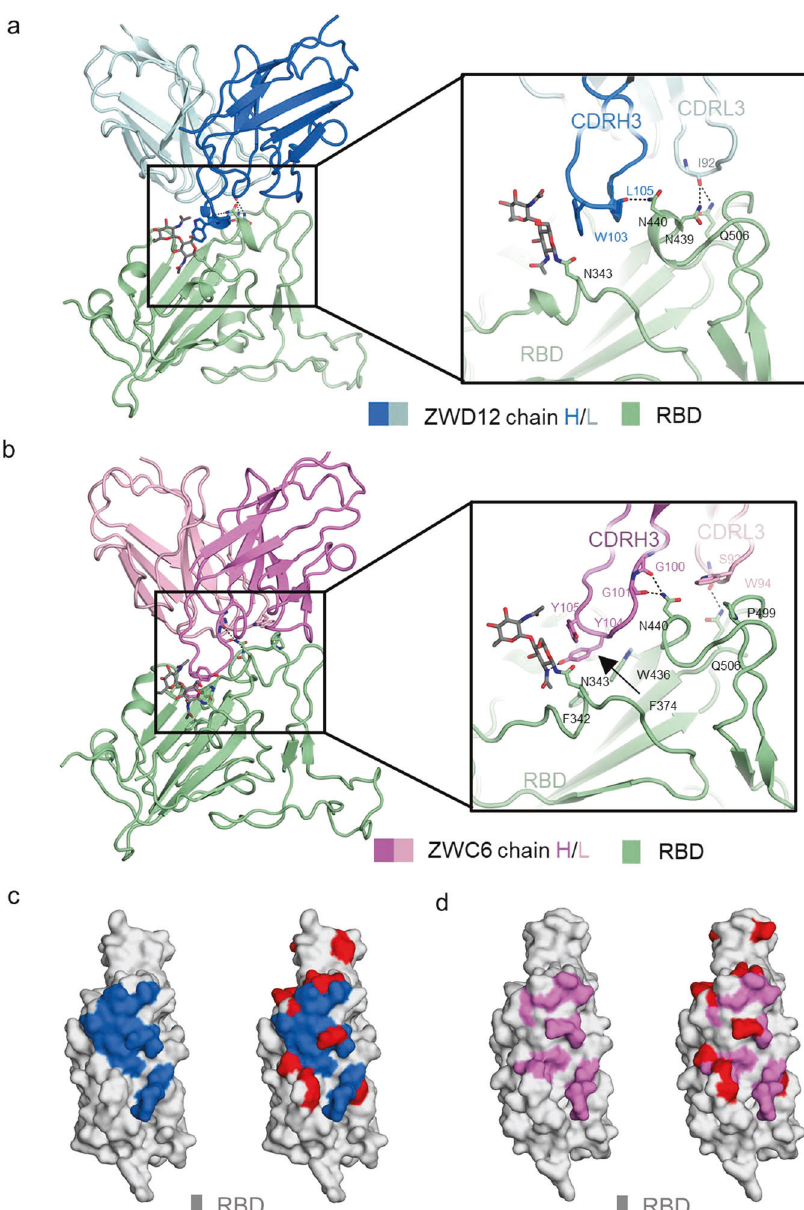
Fig. 6 Interactions between nAbs and SARS-CoV-2 RBD. Binding interface between RBD and ZWD12 ( a ) or ZWC6 ( b ). The heavy and light chains of ZWD12 and ZWC6 are colored blue, cyan, violet, and pink, respectively. RBD is colored by green. The epitopes of ZWD12 ( c ) and ZWC6 ( d ) and the near Omicron variant mutations. ZWD12 and ZWC6 epitopes are colored blue and violet, respectively. Omicron variant mutations on RBD are shown in ratio of approximately 1:5 for 1 h. Then, the mixture was subjected polyethylenimines (PEIs) (Polysciences) in 50 mL of fresh medium to size-exclusion chromatography (Superose 6 Increase 10/300 GL, for 15 min before being added to the cell culture. Cells were GE Healthcare) in buffer containing 25 mM Tris (pH 8.0) and removed by centrifugation at 4000 × g for 15 min after 60 h of 150 mM NaCl. The peak fractions were collected for EM analysis. transfection. The secreted S ECD -6P proteins were puri fi ed on an anti-FLAG M2 af fi nity resin (Sigma Aldrich). After loading two times, the anti-FLAG M2 resin was washed with wash buffer Antigen-speci fi c B cell sorting containing 25 mM Tris (pH 8.0) and 150 mM NaCl. The protein was PBMCs were stained with anti-IgG-PE (BD), anti-CD19-Alexa eluted with wash buffer containing 0.2 mg/mL fl ag peptide. The Fluor700 (Beckman Coulter), anti-CD27-PE-Cy7 (BD) antibodies, eluent was then concentrated and subjected to size-exclusion and anti-CD3-PerCP (BD) as well as with the recombinant S ECD of chromatography (Superose 6 Increase 10/300 GL, GE Healthcare) SARS-CoV-2 (Wuhan-Hu-1) at 4 °C for 1 h, followed by a two-step in buffer containing 25 mM Tris (pH 8.0) and 150 mM NaCl. The wash with PBS containing 2% FBS. The cells were then stained peak fractions were collected and concentrated before incubation with anti-FLAG tag-FITC (Thermo Fisher Scienti fi c) and anti-His tag- with a nAb. Puri fi ed S ECD -6P was mixed with the mAb at a molar APC (Biolegend) at 4 °C for 1 h. After washing twice with 2% FBS-